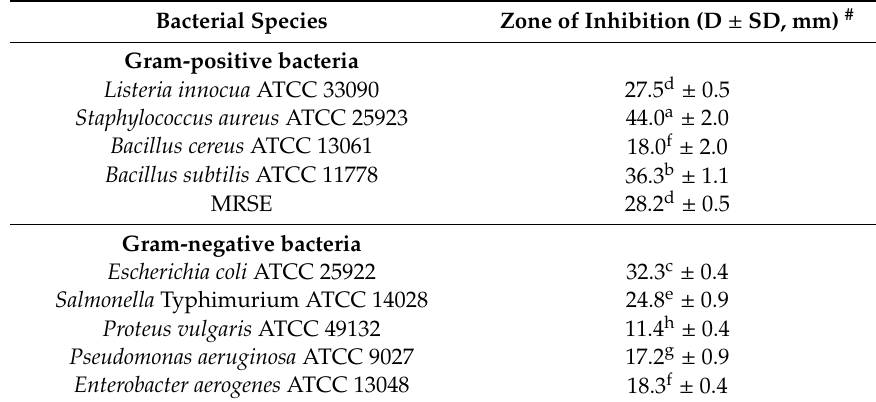
Table 1. Antibacterial activity of the cell-free supernatant of endophytic actinomycete MPT42 against selected bacteria including pathogens.